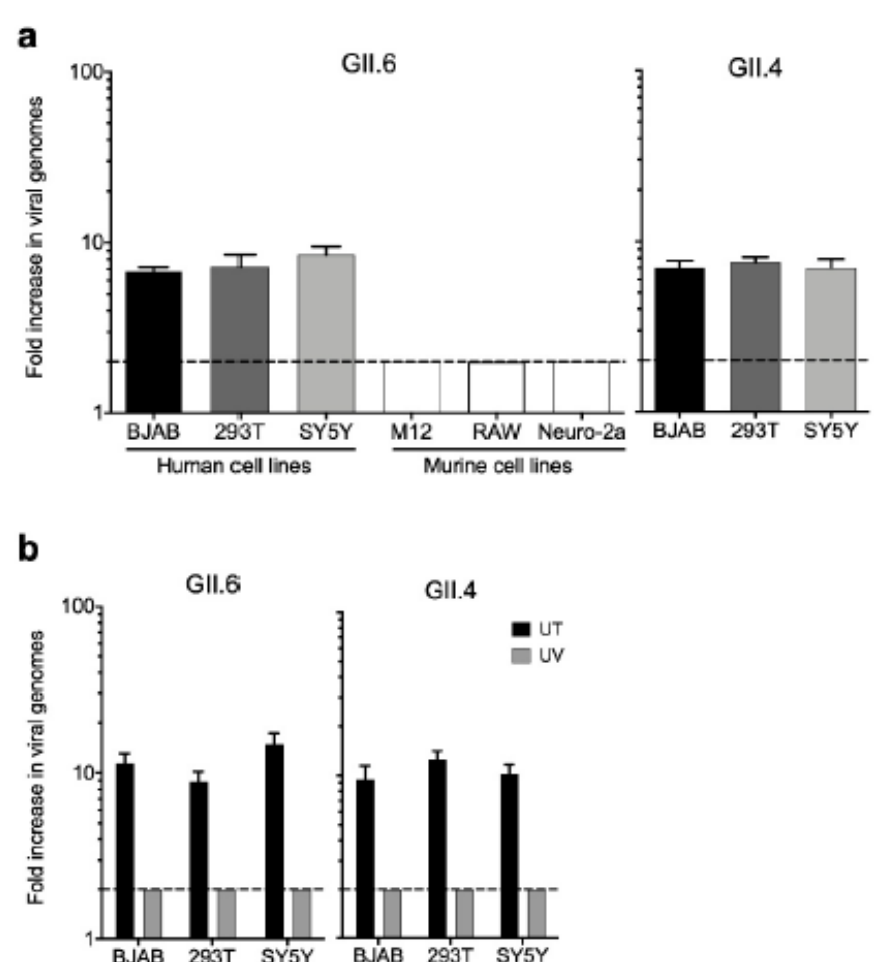
Figure 4. HEK293T cells support human norovirus replication. ( a ) Human norovirus genotypes GII.6 and GII.4 replicate in human but not murine cell lines. ( b ) Ultraviolet (UV) treatment inhibits the replication of GII.6 and GII.4 noroviruses in 3 human cell lines (UT = untreated). The dashed line represents the lower limit of detection. Error bars indicate standard error of the mean (SEM) values. Data represent the averages from 3 independent experiments.